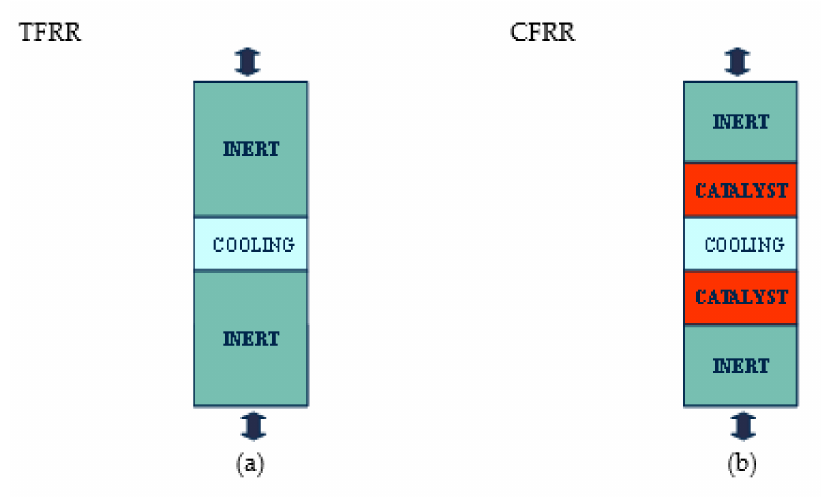
Figure 4. Scheme of two types of the FRR: ( a ) TFRR; ( b ) CFRR. Table 3. The biggest VAM abatement projects are based on regenerative thermal oxidation technology.